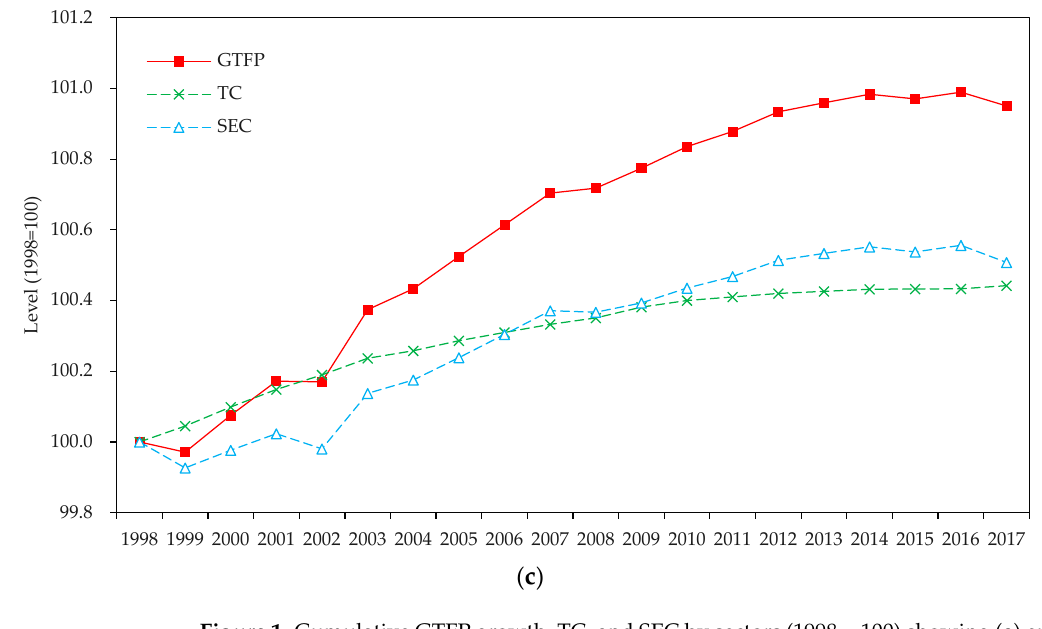
Figure 1. Cumulative GTFP growth, TC, and SEC by sectors (1998 = 100) showing ( a ) energy minerals sector, ( b ) metal minerals sector, and ( c ) nonmetal minerals sector.